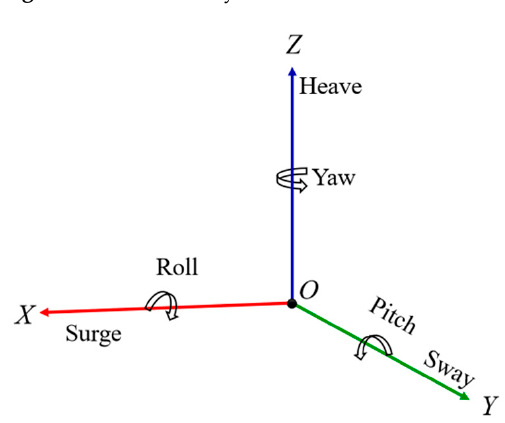
Figure 2. Degrees of freedom.